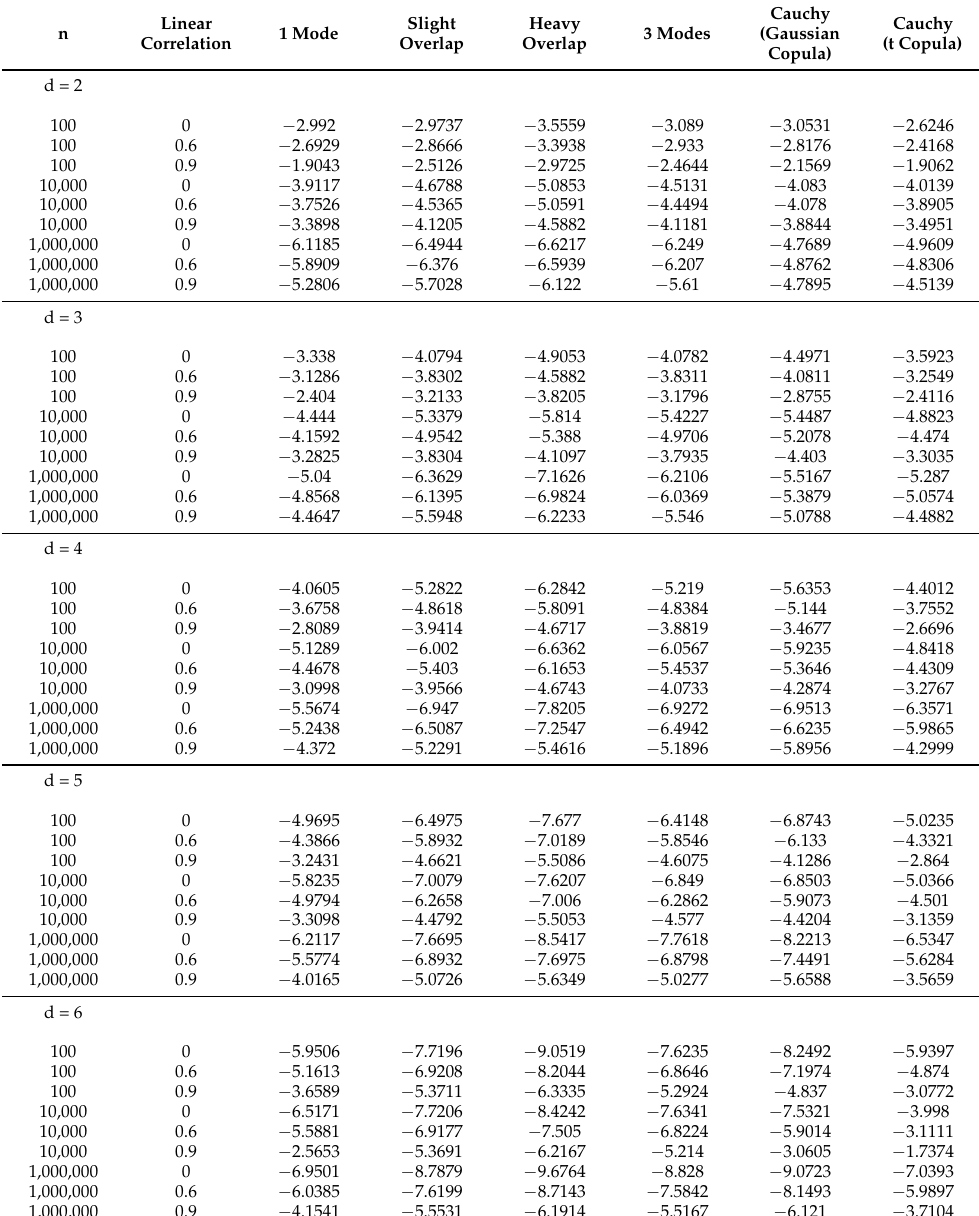
Table 2. Accuracy of new method based on synthetic data: assessed by MSE on a log base 10